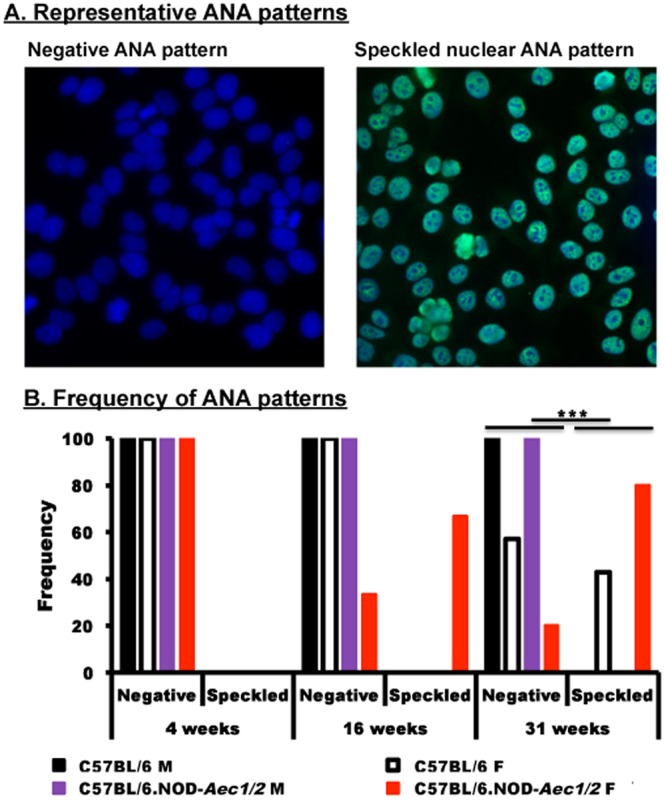
Profile of anti-nuclear autoantibody patterns. Sera of male and female C57BL/6 and C57BL/6J.NOD-Aec1Aec2 mice was incubated with HEp2 cells, followed by incubation with AF 488 goat anti-mouse IgG (green) and set with VectorShield containing DAPI (blue) with at least n=6 per sex per strain per age group. Examples of negative and speckled staining patterns are given at 100× magnification (A). The bar graph displays the frequency of animals which showed the different staining patterns (B). The experiment was repeated twice. A Chi squared test was performed, where ***P<0.00001.